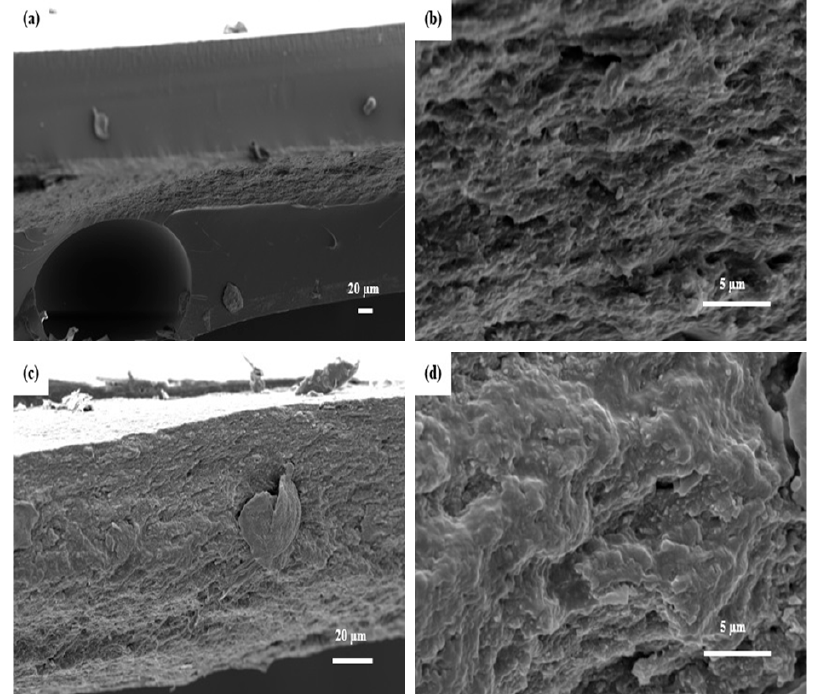
Figure 2. SEM images of fracture surfaces of cured composite made from impregnating CNFs in ( a ) epoxy/acetone solution at a ratio of 3:1 (low resolution); ( b ) epoxy/acetone solution at a ratio of 3:1 (high resolution); ( c ) epoxy/acetone solution at a ratio of 1:3 (low resolution); and ( d ) epoxy/acetone solution at a ratio of 1:3 (high resolution).